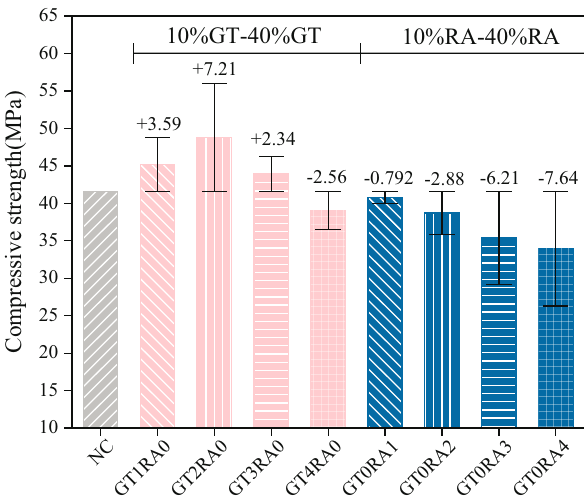
Figure 7: Compressive strength of concrete from GT and RA.